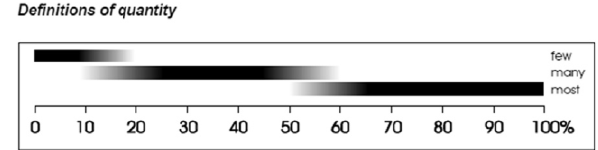
Figure 3. Definitions of quantity of